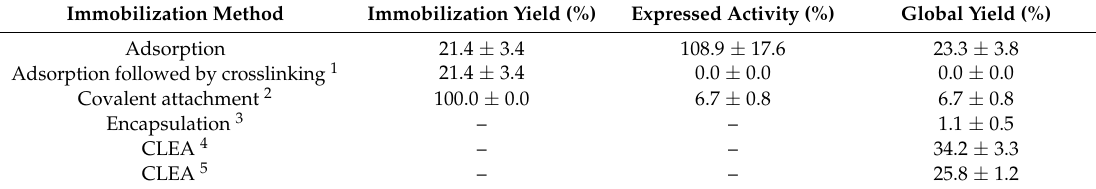
Table 1. Carrier-bond immobilization using chitosan 2% (for adsorption and covalent attachment), 1% (for encapsulation) and free-carrier immobilization (CLEA) without feeder protein. It was supplied 0.53 mg of protein per gram of carrier in each immobilization method using